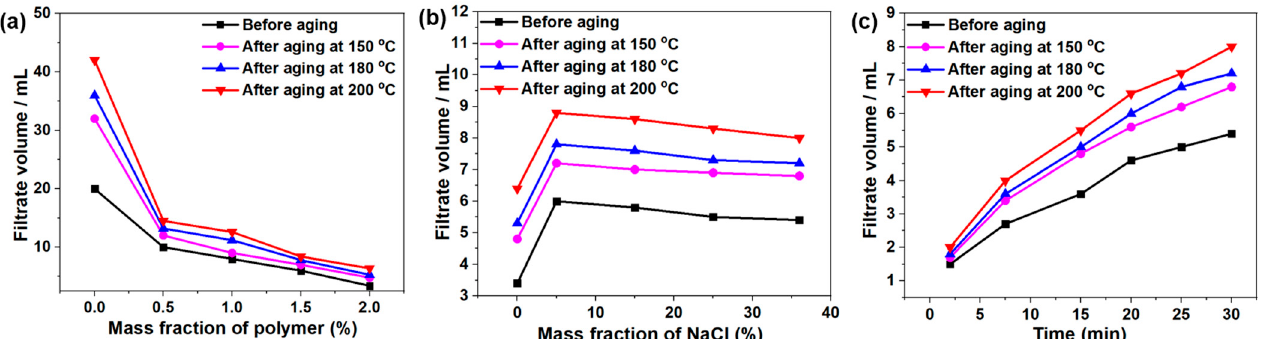
Figure 5. ( a ) API filtration loss of DDAM-based drilling fluid before aging and after aging at 150 °C, 180 °C and 200 °C for different contents. ( b ) API filtration loss of 2 wt% DDAM-based drilling fluids with different fraction of NaCl before aging and after aging at 150 °C, 180 °C and 200 °C. ( c ) API filtration loss of 2 wt% DDAM-based drilling fluids in saturated salt environment before aging and after aging at 150 °C, 180 °C and 200 °C for different time.